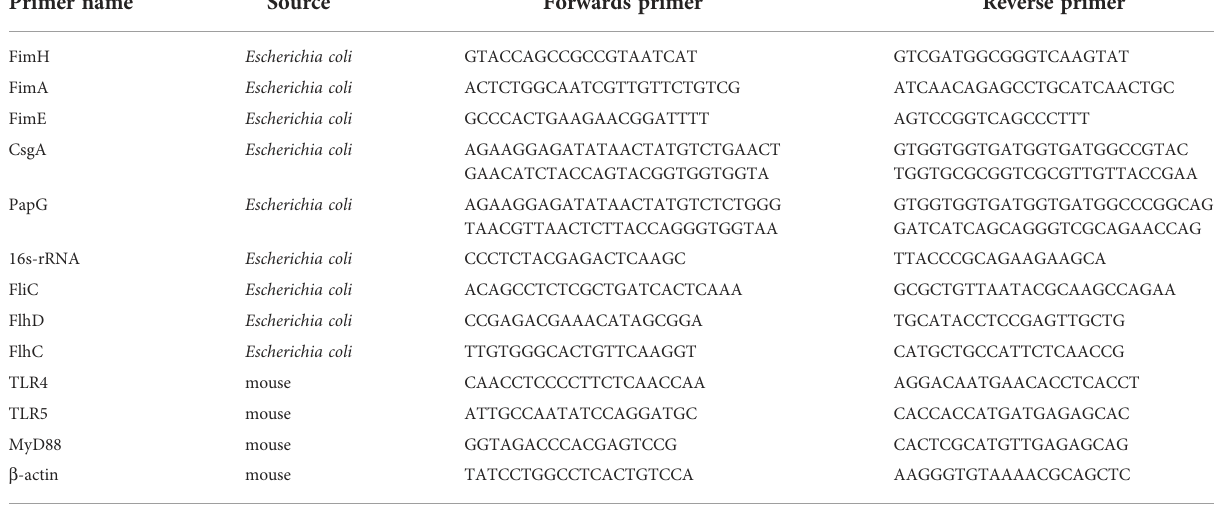
TABLE 1 Sequence of the primers used in this